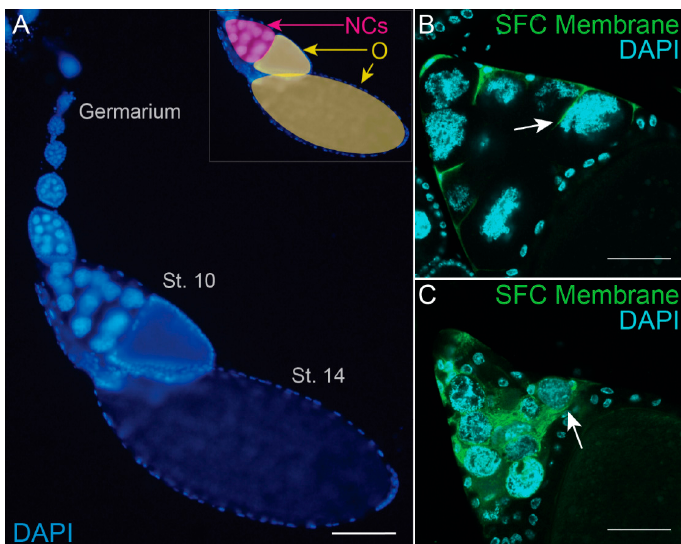
Figure 5. The Drosophila ovary. ( A ) An image of a single ovariole stained with DAPI to label DNA. Oogenesis begins in the germarium and ends with a fully developed Stage 14 egg chamber. During the late stages of oogenesis, nurse cells (NCs) dump their cytoplasm into the oocyte and are eliminated. This dramatic change is readily seen when comparing the Stage 10 egg chamber in which NCs take up about half of the egg chamber (inset, pink region) to Stage 14 when NCs have been eliminated (inset, yellow region). ( B ) Stretch follicle cell (SFC) > Myr-GFP Stage 11 egg chamber stained with DAPI. SFC membranes (green, arrow) begin to surround NCs as they dump their cytoplasmic contents into the oocyte. ( C ) SFC > Myr-GFP Stage 13 egg chamber stained with DAPI. SFC membranes (green, arrow) completely surround NCs. All scale bars = 50 µm.